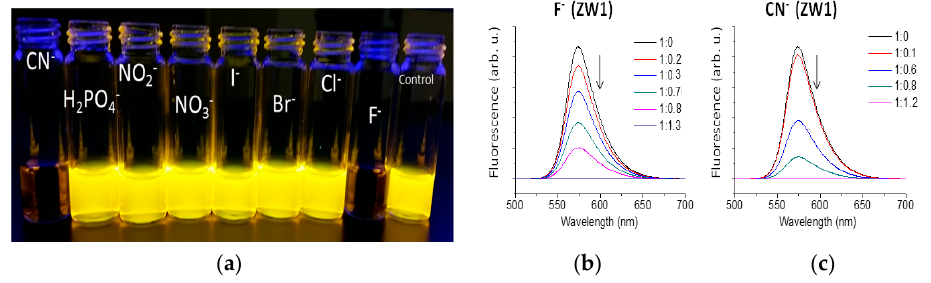
Figure 8. ( a ) Fluorescence response of ZW1 in acetonitrile upon the addition of different anions. Spectrophotometric fluorescent titrations of ZW1 in acetonitrile with a solution of tetraethylammonium ( b ) Fluoride (10 mM) and ( c ) Cyanide (10 mM) in acetonitrile. The arrows indicate the evolution of the emission band for anion/ZW1 molar ratios from 0 to 1 (fluorescence, [ZW1] = 3.0 × 10 − 6 M). Note that the equimolar addition of fluoride or cyanide results in the nearly complete suppression of the emission from the sample and, consequently, no fluorescence spectrum is visible in these cases in the pictures.